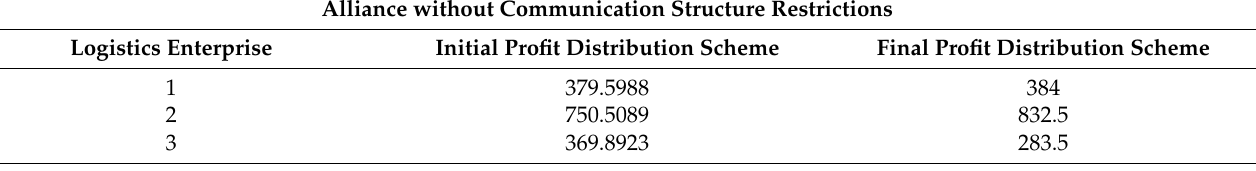
Table 8. Summary and comparison of the profit distribution